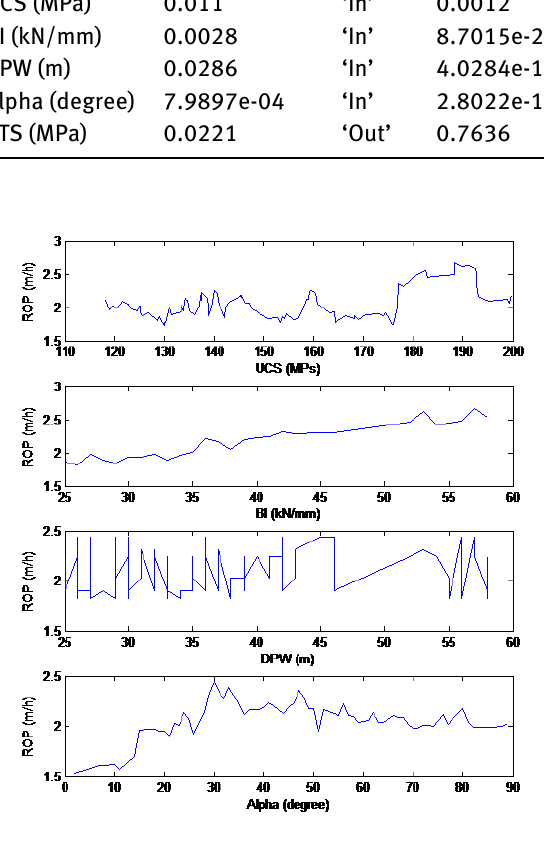
Figure 2: Rock engineering properties on ROP.